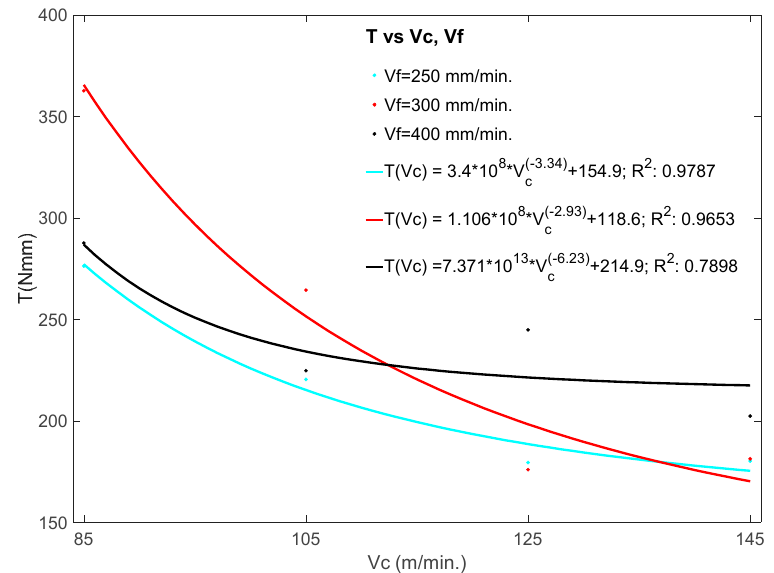
Figure 5. Effects of cutting speed and feed rate on the torque ( T ).